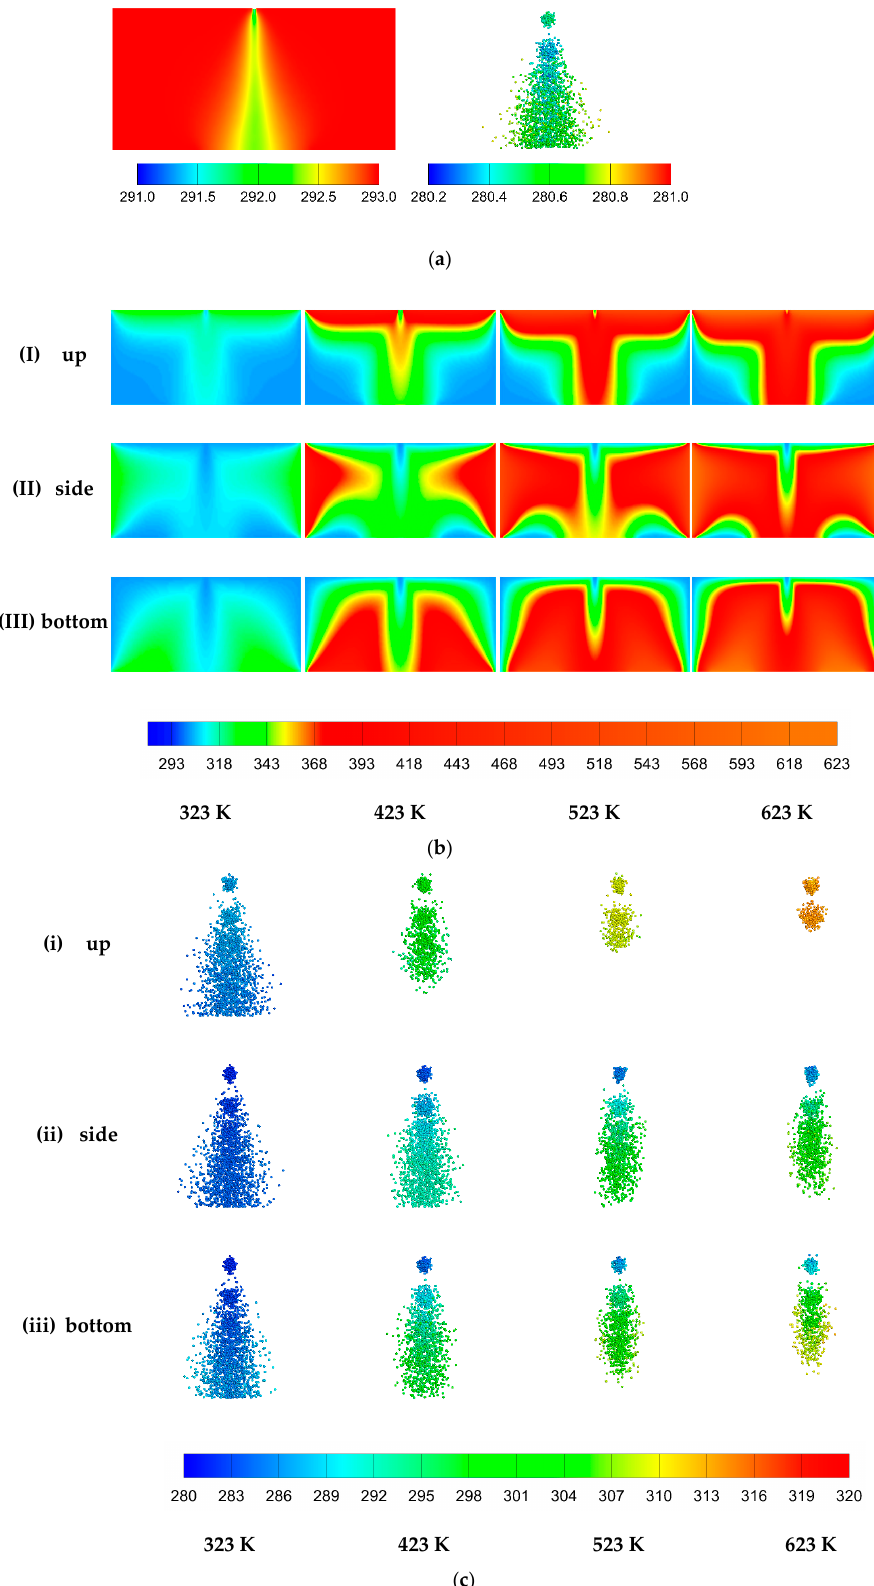
Figure 7. The temperature distribution of the flow field and droplets at different heating temperatures of the external mixing nozzle. ( a ) shows the temperature distribution of the flow field and droplets without heating. ( b ) shows the temperature distribution of the flow field under different heating surfaces and ( c ) represents the temperature distribution of the droplets under different heating surfaces. Figure 7(I) and (i) show the temperature distribution of the flow field and droplets at different heating temperatures of the top heating wall. The upper part of the flow field has a lower temperature from the top wall to the bottom wall, and the central area near the lower half of the axis is higher than that of the outer part with the lowest temperature. The temperature at the spout of the nozzle is the highest. The closer to the bottom wall, the lower the temperature. When the heating temperature increases, the evaporation rate becomes larger. Since the flow rate is small, the atomized droplets are completely evaporated before arriving at the bottom wall outlet. When the spray is heated by the side heating wall, the temperature distribution in the flow field is similar to that of the internal mixing nozzle, given in Figure 7(II) and (ii). The temperature of the sidewall is the highest, while the temperature at the top wall, the spout, and the outer ring of the bottom wall are the lowest. Because it is heated all around, the droplets on the outside of the spray are first evaporated, and the range of spray has become shorter. In Figure 7(III) and (iii), the temperature distribution in the flow field resembles that of the internal mixing nozzle for the different heating temperatures of the bottom wall. It is worth noting that if the droplets are completely evaporated before moving to the outlet at certain heating temperature, the different heating positions will cause the different farthest moving distance of the droplets. The distance is the largest under the condition of side heating, followed by the bottom heating and finally top heating.